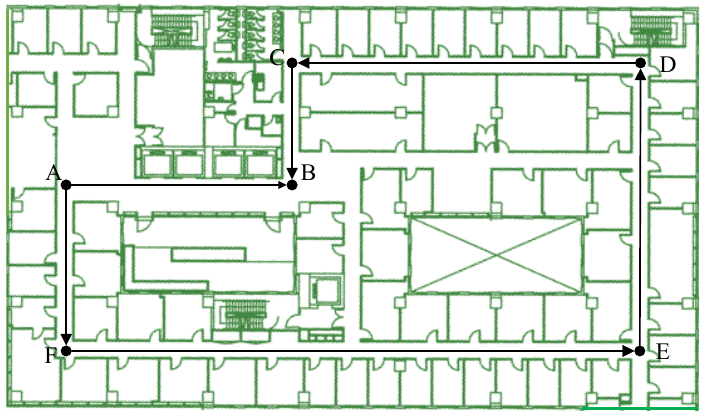
Figure 4. Experimental site of first scene.